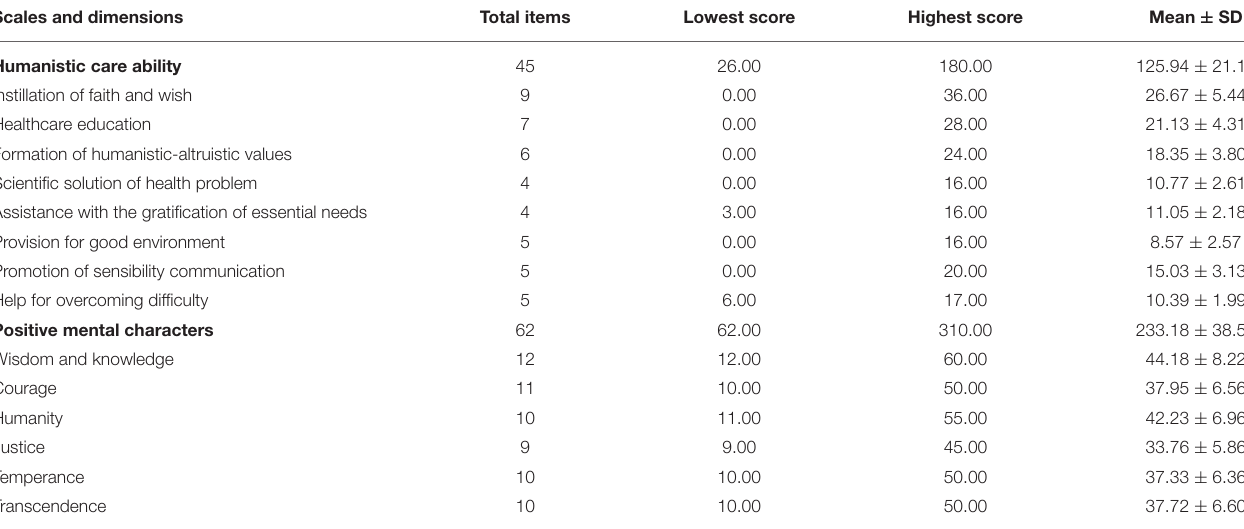
TABLE 2 | Scores of humanistic care ability and positive mental characters for nursing students, Changsha, Hunan ( N = 981). Scales and dimensions